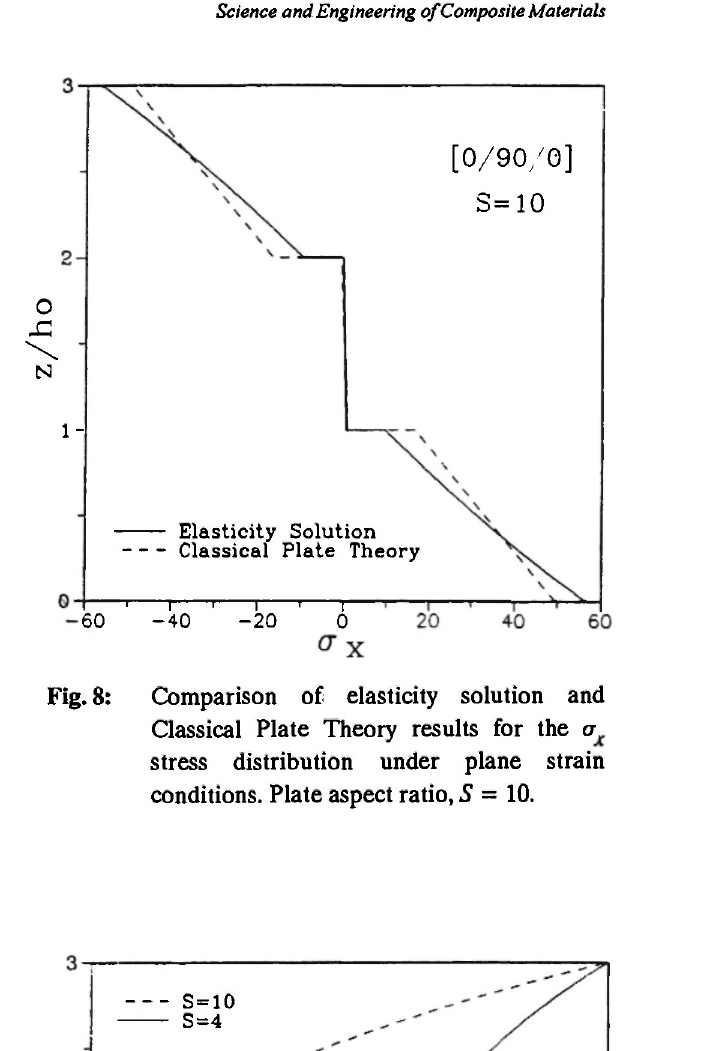
Fig. 7: Comparison of elasticity solution and Classical Plate Theory results for the σ χ stress distribution under plane strain conditions. Plate aspect ratio, S = 4.